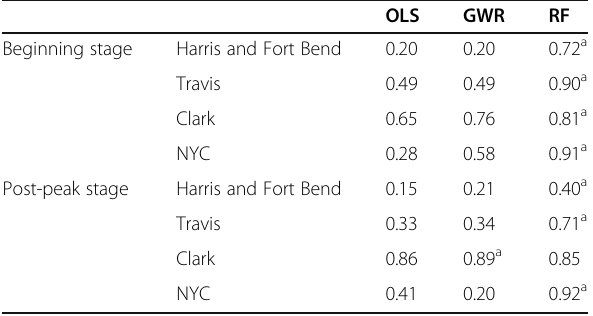
Table 4 Model performance based on R-square